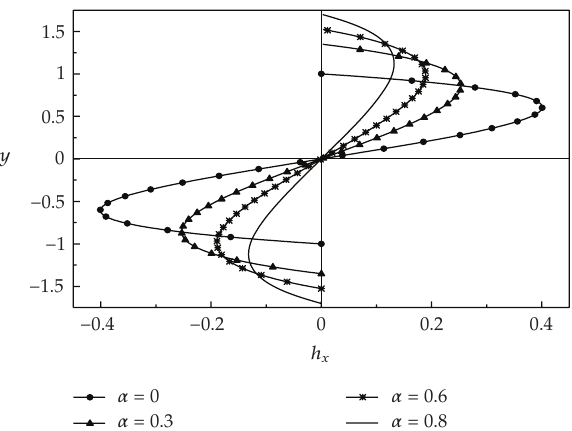
Figure 9: Variation of the axial-induced magnetic field across the channel for m (cid:8) 3 , N (cid:8) 0 . 6 , H (cid:8) 4 , R m (cid:8) 2 , θ (cid:8) − 1 . 2 and di ff erent values of α .